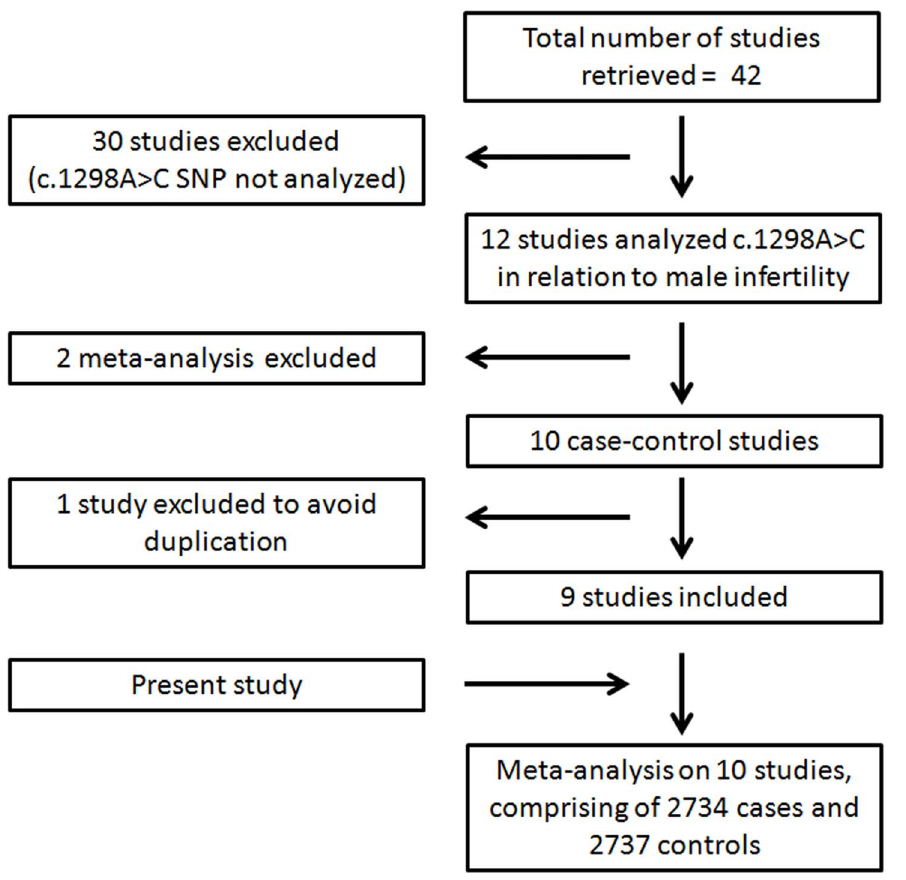
Figure 2. Flow diagram showing inclusion and exclusion of the studies for meta-analysis. Studies retrieved upon literature search were subjected to inclusion/exclusion criteria as detailed in the methods section.